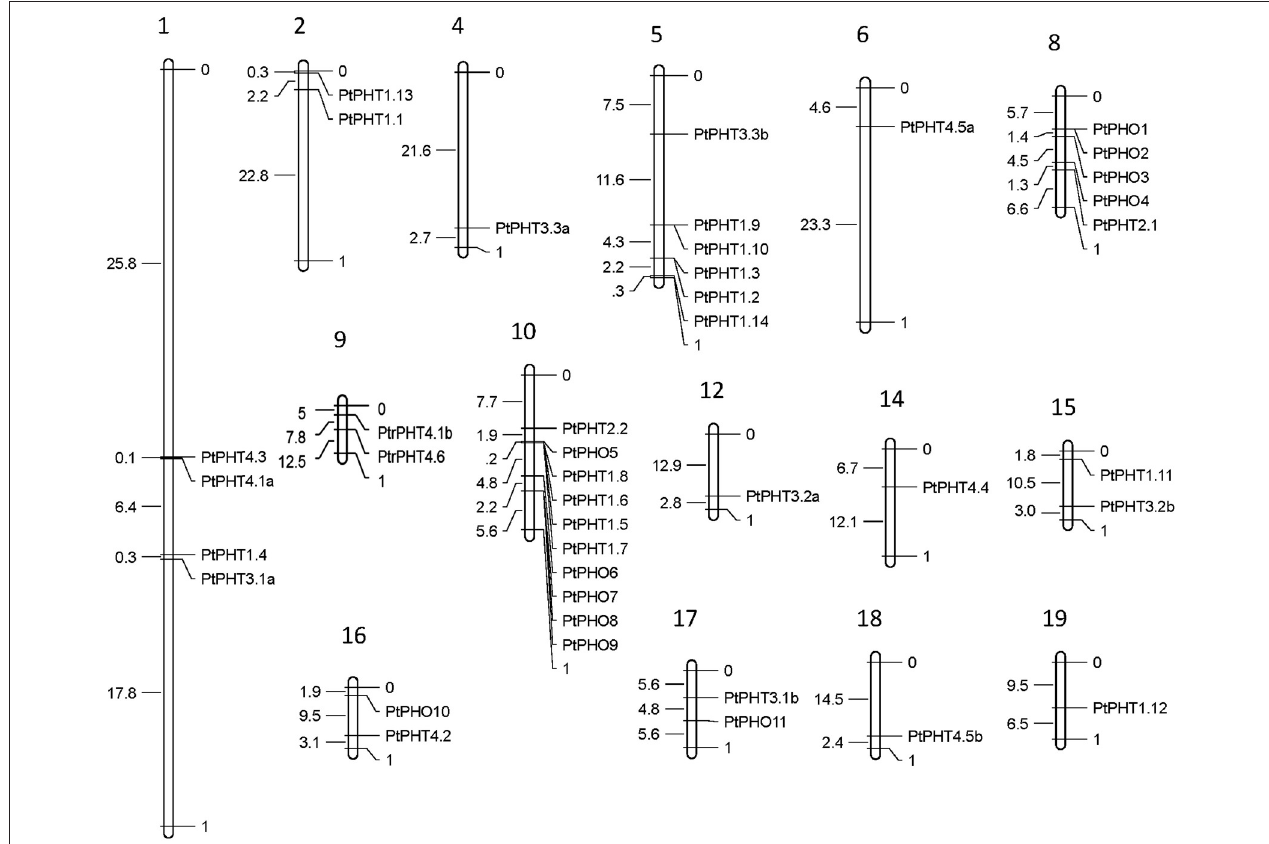
FIGURE 2 | Chromosomal locations of Populus PHT family members. The chromosomal locations of the PHT genes were mapped with MapDraw program (Liu and Meng, 2003